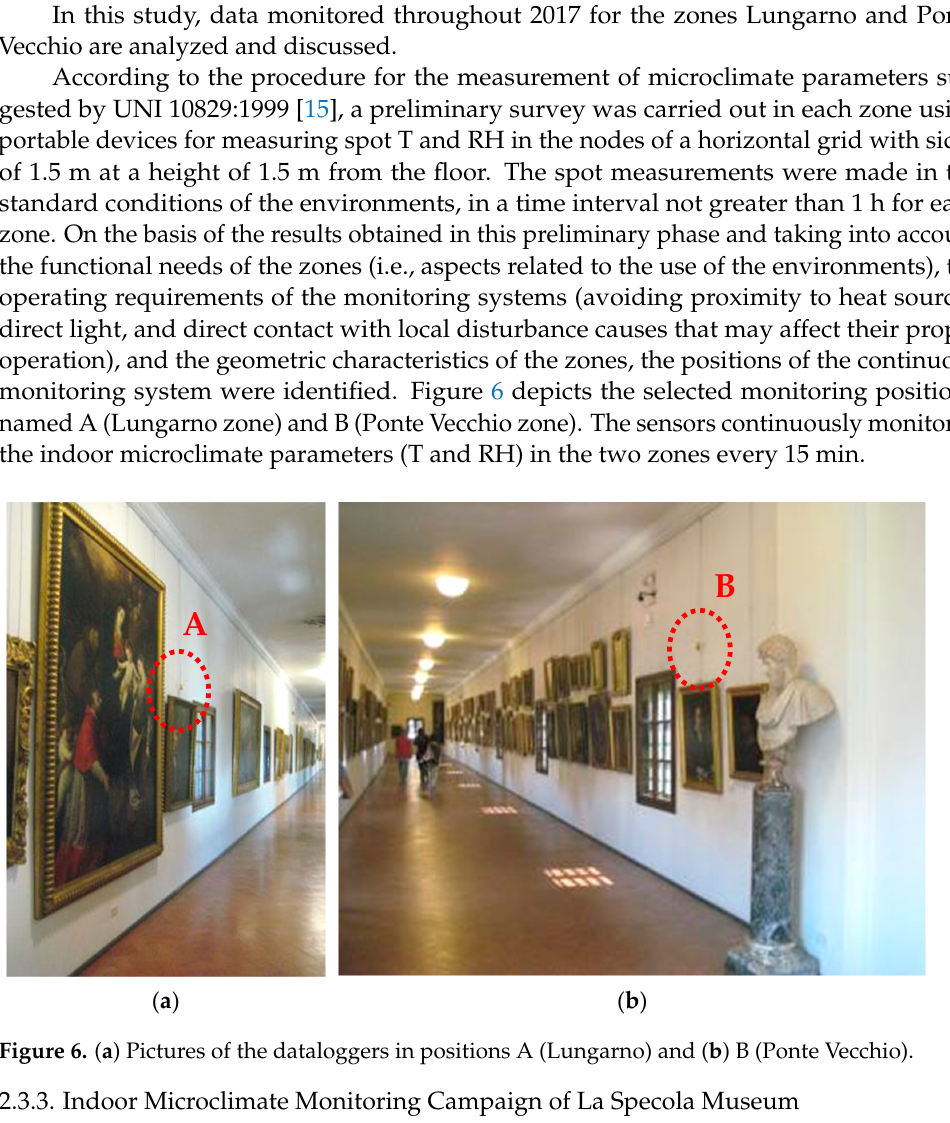
( b ) Figure 7. ( a ) Pictures of the dataloggers in room X and ( b ) room XXII.